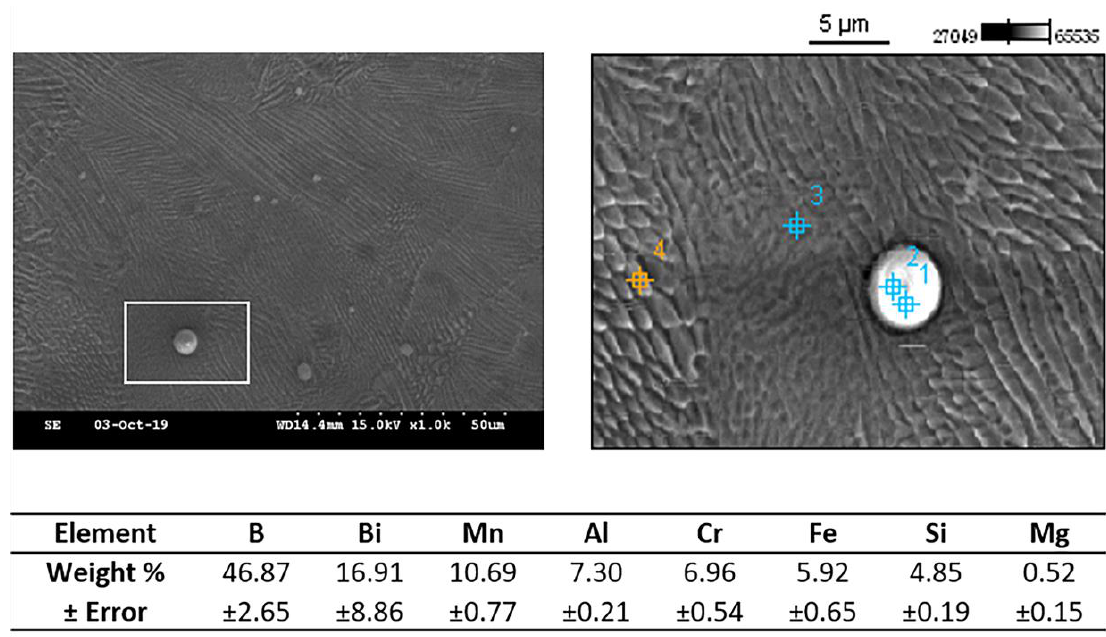
Figure 16. EDX analysis of the residual spherical particles seen after experiment 2B. The average values from locations 1 and 2 were listed in table, while the values from location 3 and 4 were measured for references.